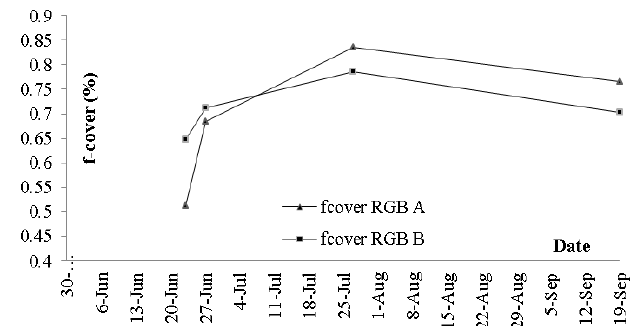
Figure 11: The f-cover percent in two treatments (A: control, B: test) and in their critical growth